Question: Does the figure show an increasing or a decreasing trend?
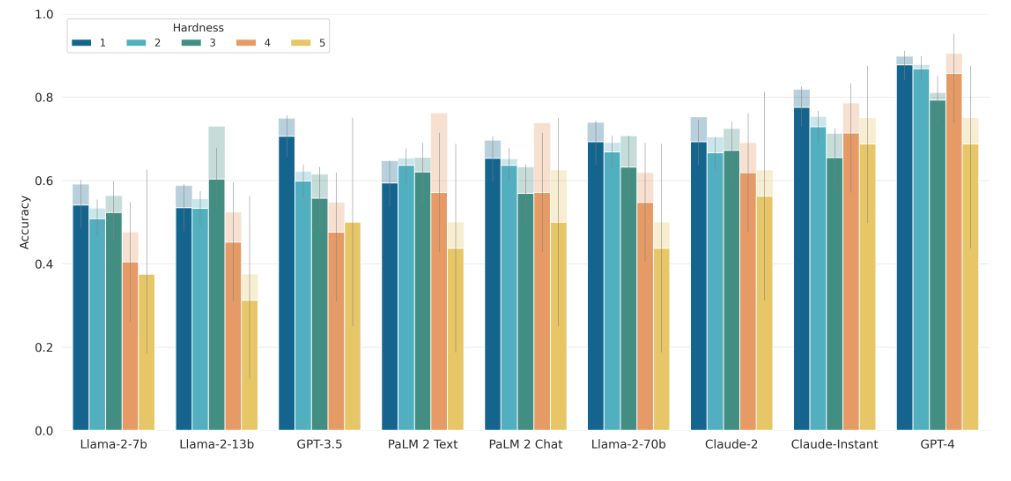
Answer: increasing